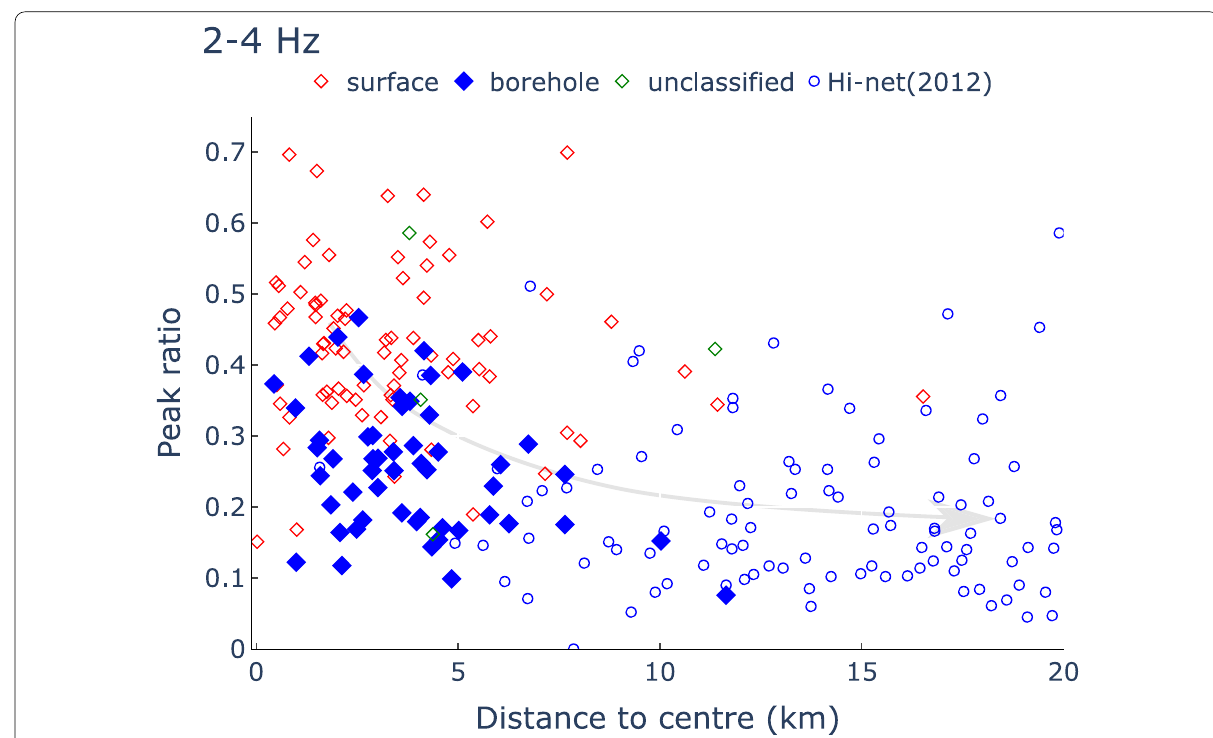
Fig. 4 Peak amplitude ratio plotted against the estimated distance to the volcanic centre according to the 4th edition National Catalogue of the Active Volcanoes in Japan (Japan Meteorological Agency 2013). The plots are for the JMA stations at the frequency band of 2–4 Hz. JMA stations can be differentiated into ground surface (red) and borehole (blue) stations. Stations with green symbols are not classified on the JMA website. Also shown are peak ratios at Hi-net borehole stations that are within 20 km of volcanoes (Nishimura 2012). Overall, the JMA ground surface stations show larger peak ratios than their borehole counterparts. For the JMA borehole stations, we see an ostensible decay in peak ratio with distance. This pattern is continued by the Hi-net